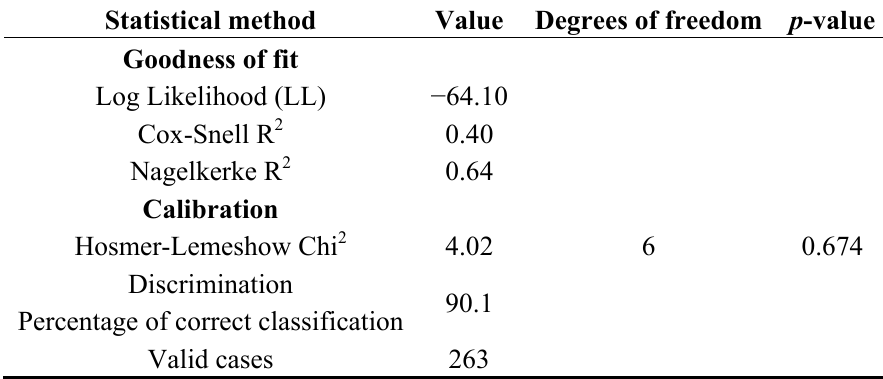
Table 2. Fitness, calibration and discrimination of the logistic regression model (LRM).